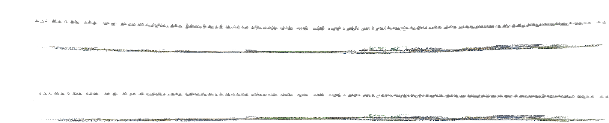
Figure 2: Illustration of the ”bending”-effect (top). Camera po- sitions and 3D points drift away from fixed control points